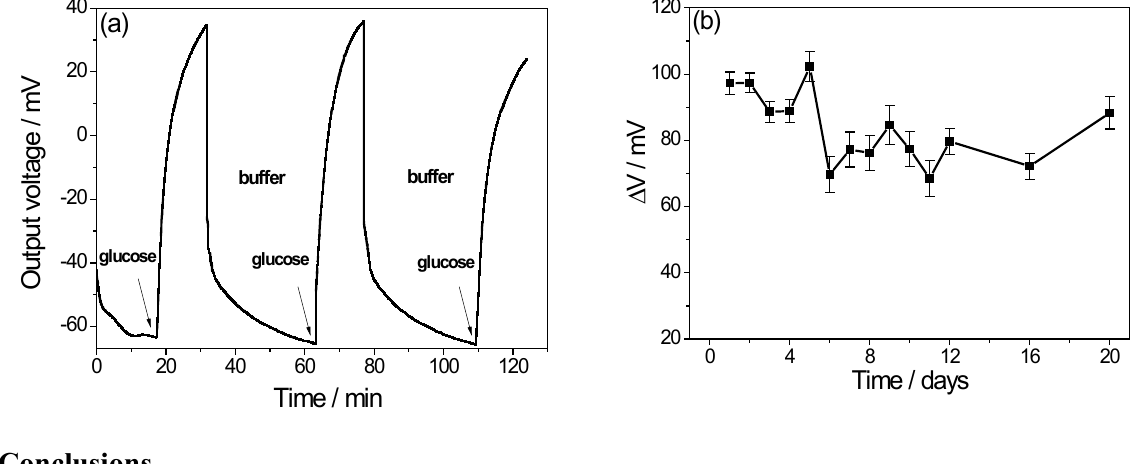
Figure 5. PPI/NiTsPc-GOx FET-based glucose biosensor response after successive immersions in buffer and in buffer solutions containing 0.5 mM of glucose (a) and lifetime of the biosensor stored in pH 7.5 buffer solution at 4 °C (b)